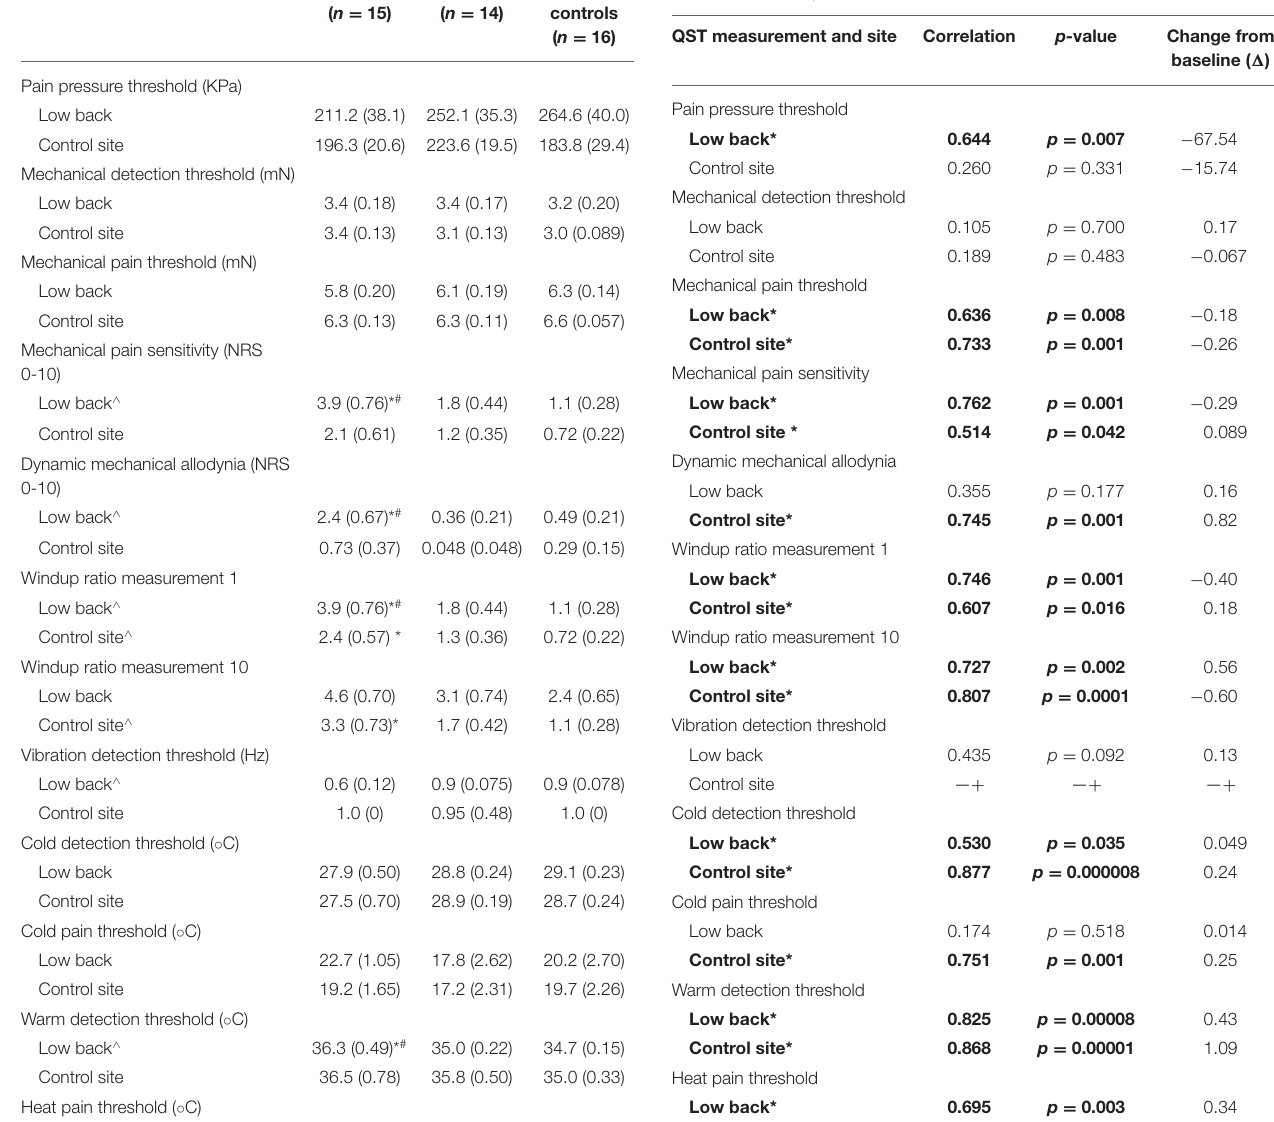
TABLE 3 | Quantitative sensory testing (QST) measures at the time of pain onset. QST measurement and site